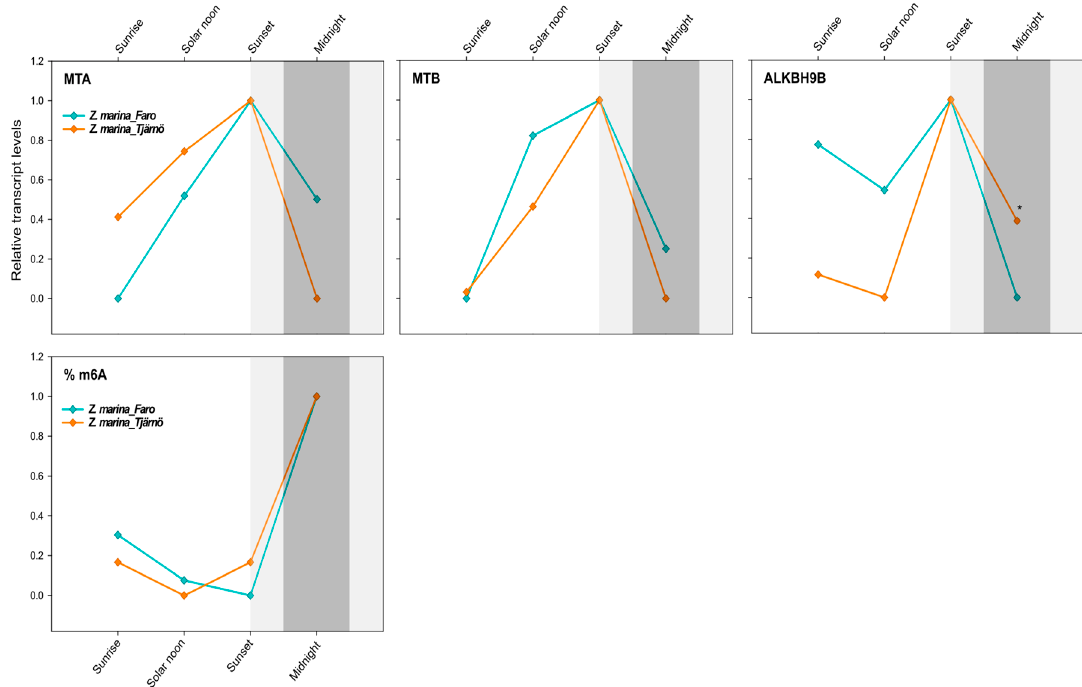
Figure 5. Daily transcript levels (as normalised − ∆ CT data) of writer (MTA and MTB) and eraser (ALKBH9B) genes and % of global m 6 A (normalised data) in Z. marina at Ria Formosa lagoon, Faro—Portugal (Lat. 37.019356) and at Tjärnö, Strömstad—Sweden (Lat. 58.879724) (intraspecific analysis). Asterisks represent significant differences between species at the specific time points, as resulting from SNK post-hoc tests following a two-way ANOVA. Light and dark grey boxes highlight the twilight and night times, respectively. * p < 0.05.